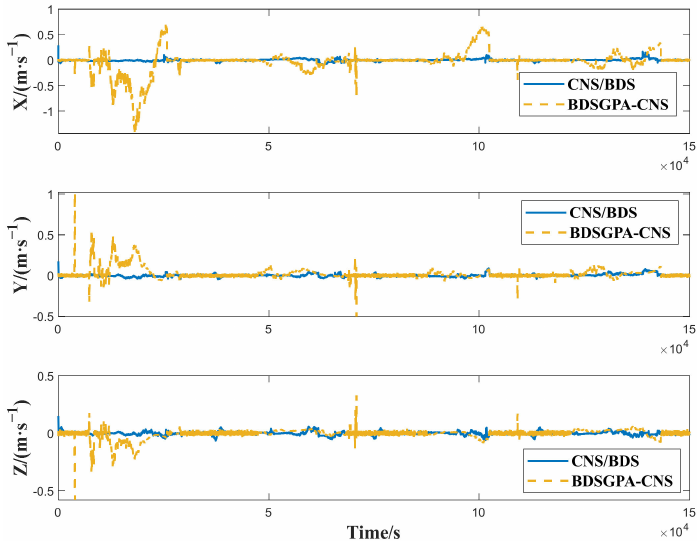
Figure 11. Velocity error in three directions. Table 6. Comparison of CNS/BDS integrated navigation and BDSGPA-CNS navigation errors.